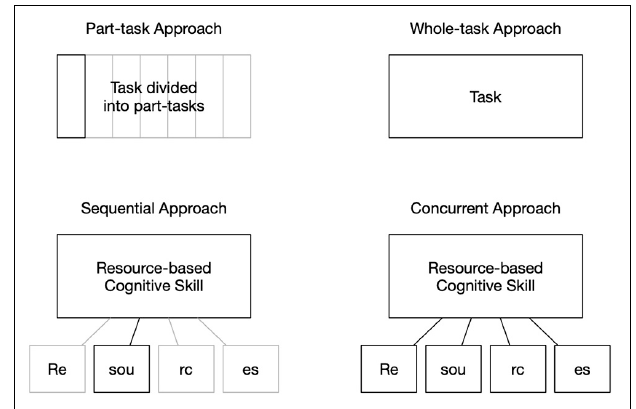
FIGURE 1 | Structural equivalence between the part-/whole-task debate (upper part) and the sequential and concurrent approach to support a resource-based cognitive skill and its resources (lower